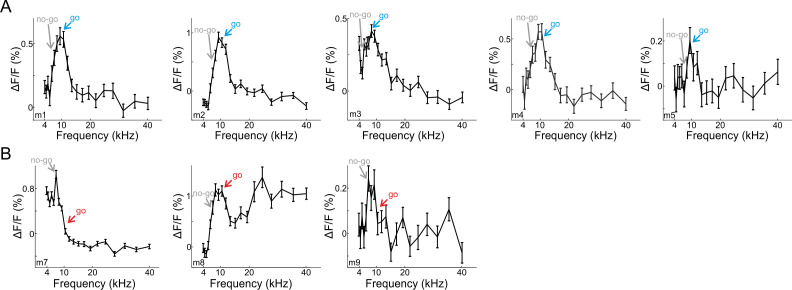
Frequency tuning for each mouse.(A) Frequency tuning curve tuned for the go frequency. The frequencies used as go, and no-go are marked. Mouse six did not have a frequency curve. (B) Frequency tuning curves for the three mice that are tuned away from the go frequency.